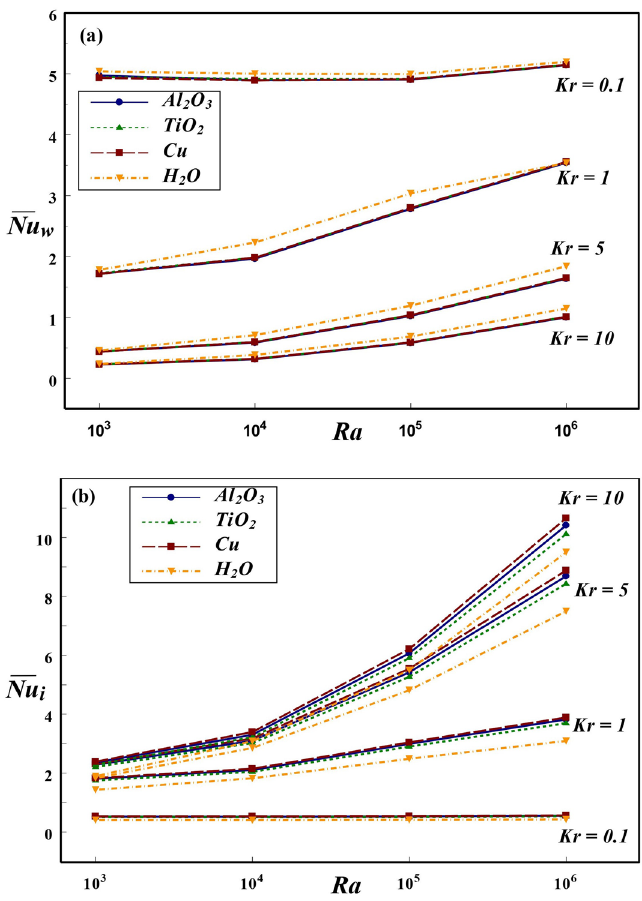
Figure 8. Effect of Ra and Kr on Nu at the ( a ) wall and ( b ) interface for ε = 0.2 and φ = 0.1